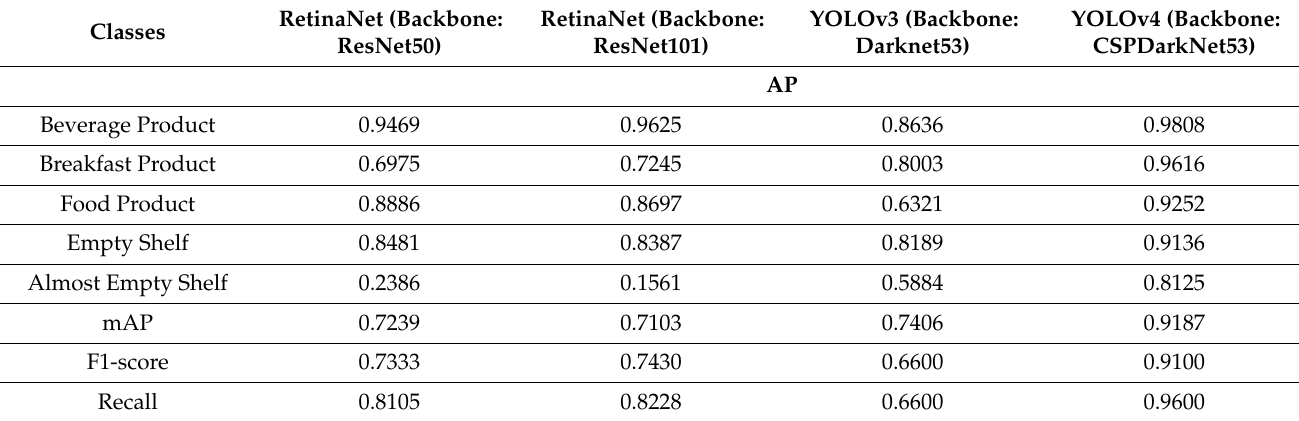
Table 2. Comparison of success rates of the methods on the labeled images for three different one-stage detectors with four different